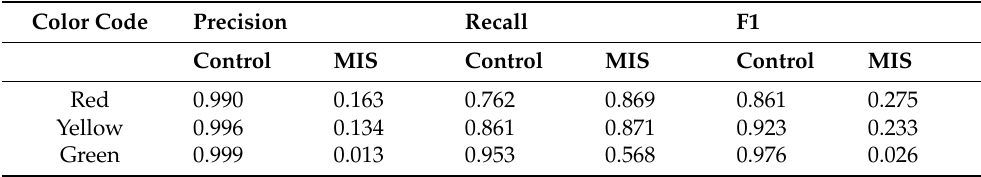
Table A3. Neural network performance across color codes.